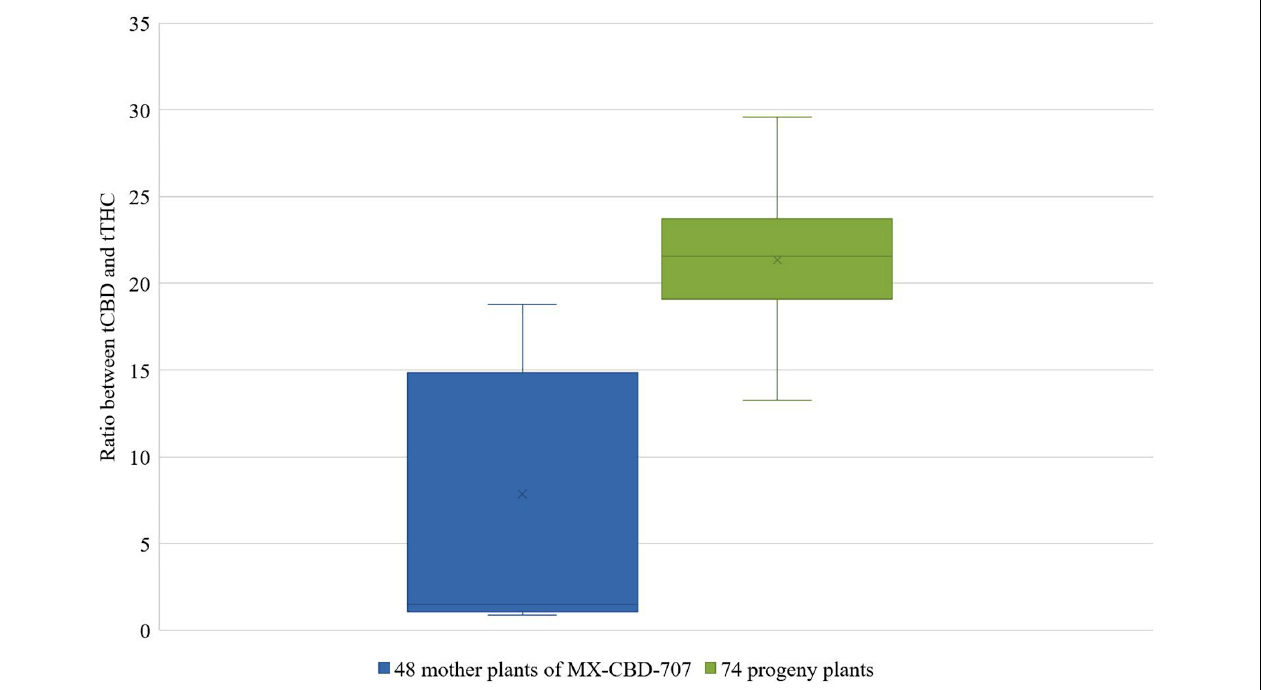
FIGURE 3 | Distribution of the ratios between tCBD and tTHC in 48 mother plants of breeding population MX-CBD-707 (left-blue) and 74 of their progeny